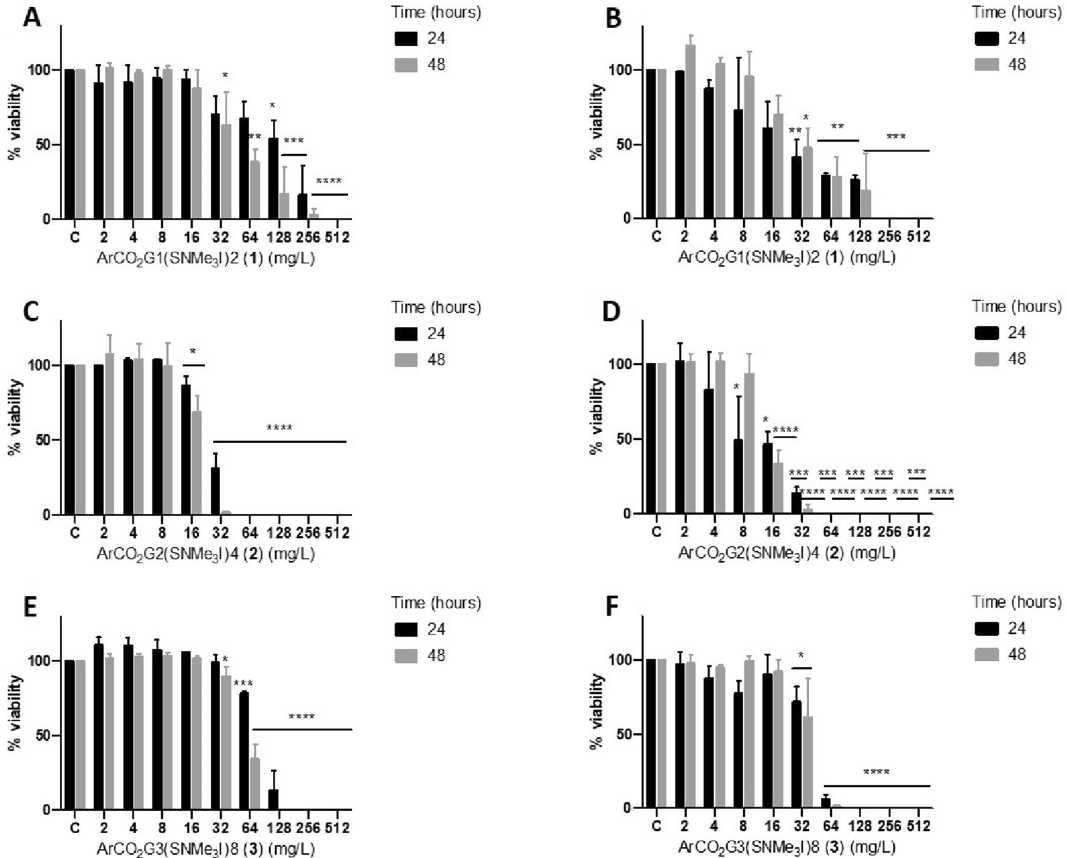
Figure. 2. Viability percentage of trophozoites treated with dendritic compounds. A. griffini MYP2004: ( A )